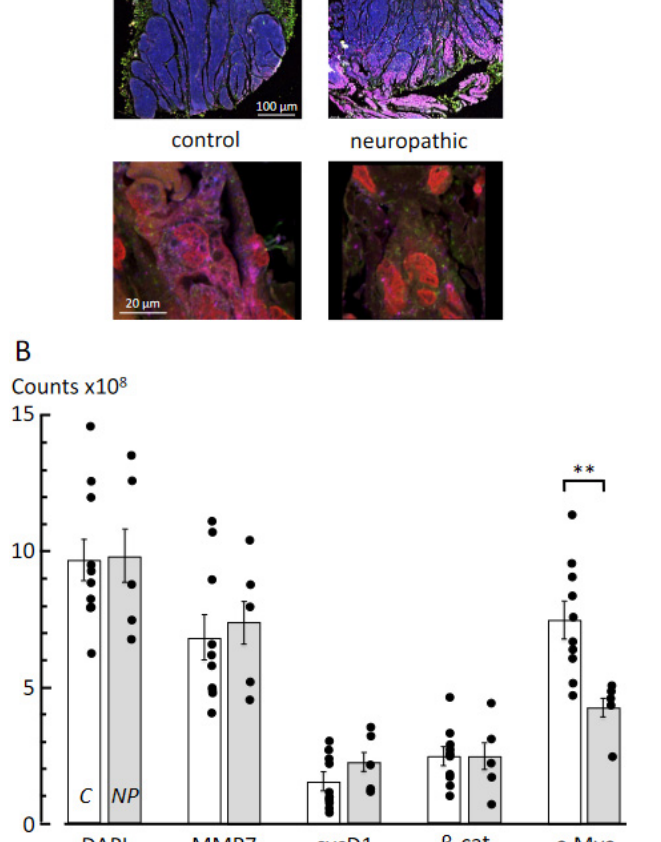
Figure 3. Multiplex immunofluorescence image analysis of control and neuropathic bladder samples. ( A ): Protein expression for MMP7, cyclinD1, β -catenin and c-Myc (DAPI used as counterstain) was measured in bladder tissue samples. Representative images at low magnification (20 × , top lane, scale bar 50 µ m) and high magnification (63 × , bottom panel, scale bar 20 µ m) for control and neuropathic bladder tissue. Images are composite overlays of four fluorophores: Cy3 (yellow) for MMP-7; Cy5 (purple) for cyclin-D1; FITC (green) for β -catenin; Cy3.5 (red) for c-myc; DAPI nuclear label (blue). The higher magnification images show each label clearly, relative to the low-magnification images. ( B ): Quantitative, intensity, analysis was performed on 63 × images subsequent to fluorophore channel separation (see methods) from control (C, empty bars n = 9) and neurogenic LUT dysfunction bladder samples (NP, grey bars, n = 5), using Huygens analysis software (SVI). The expression of c-Myc was significantly (** p < 0.01) different between control and neurogenic LUT dysfunction bladders.